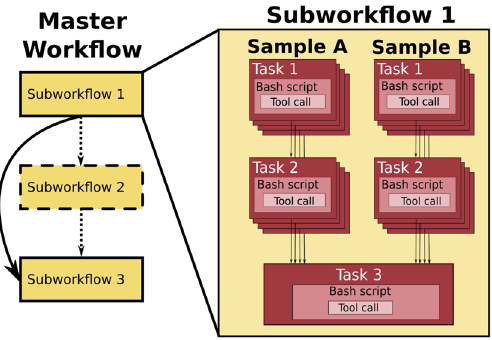
Figure 2. Bioinformatics workflows with multiple levels of complexity warrant a modular construction. It is easiest to program the workflow when its logic is abstracted away (in Tasks, red) from the command line invocations (in Bash scripts, pink) of the bioinformatics tools (light pink). Individual workflows can be further used as subworkflows of a larger Master workflow (e.g., Fig Supplementary 1). This architecture facilitates expression of additional complexity due to optional modules (dashed line), nested levels of parallelism (groups of arrows connecting red rectangles) and scatter-gather patterns (task 2 scattered across samples being merged into task 3).